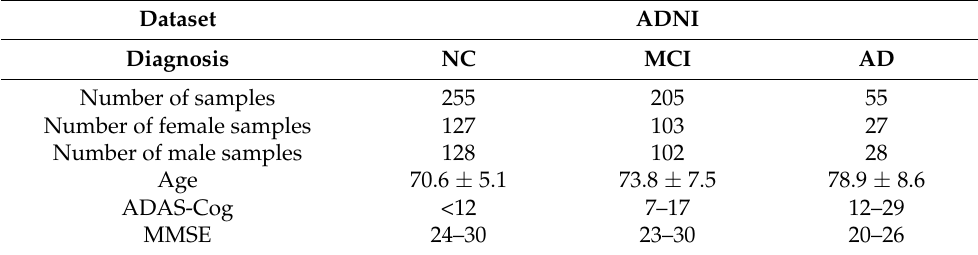
Table 1. Information of subjects from ADNI dataset used in this